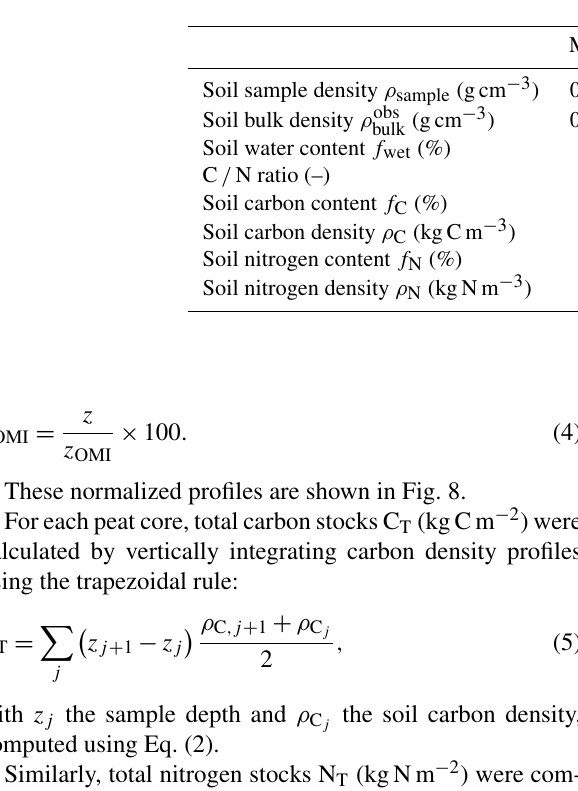
Figure 5. Distribution histograms ( n samples = 135) of (a) soil sample density ρ sample (gcm − 3 ), (b) soil bulk density ρ obs water content (%), (d) C / N ratio (–), (e) soil carbon content f C (%), (f) soil carbon density ρ C (kgCm − 3 ), (g) soil nitrogen content f N (%), and (h) soil nitrogen density ρ N (kgNm − 3 ). Red lines represent mean values, blue lines median values, dashed green lines upper and lower deciles. Table 2. Data statistics and dispersion (mean, median, lower and upper